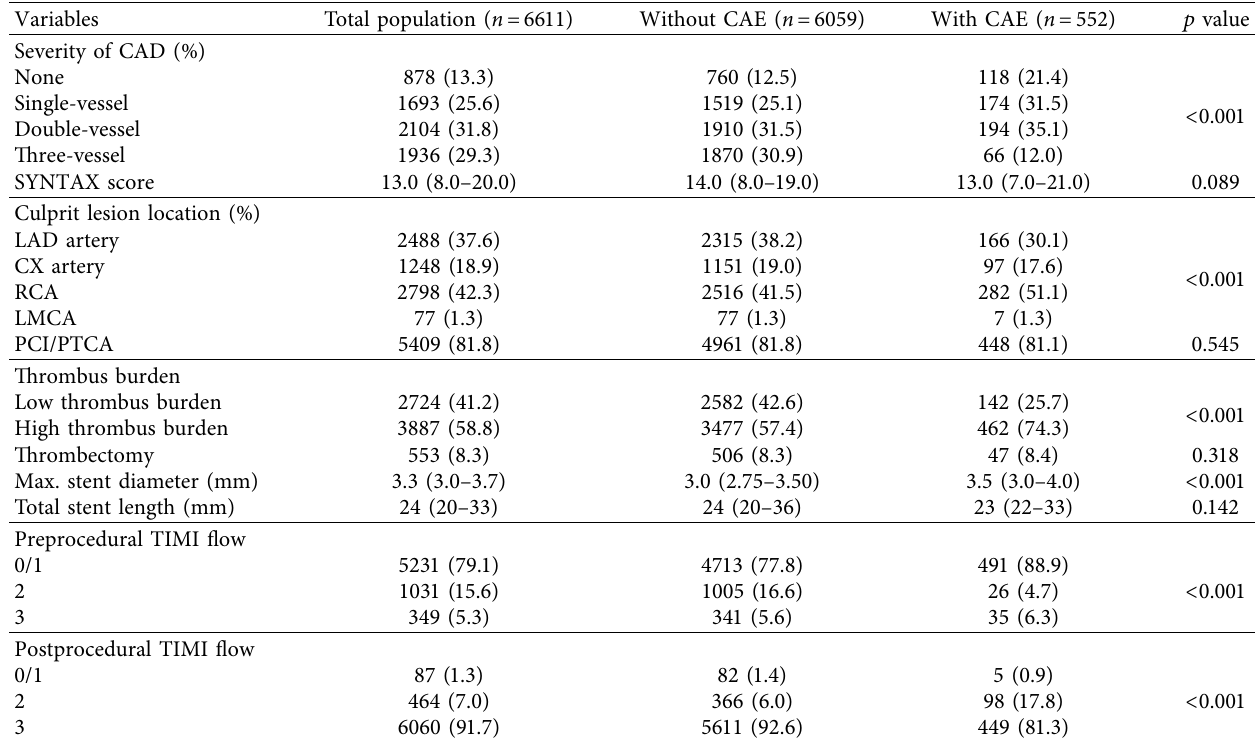
Table 2: Angiographic and procedural characteristics of the study